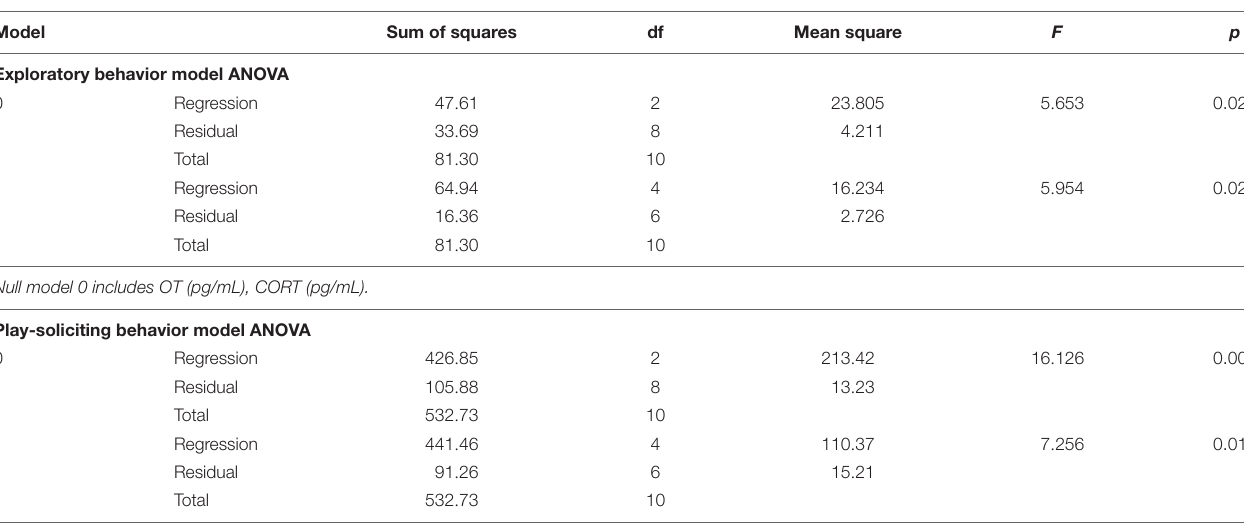
TABLE 4 | Hierarchical multiple regression model